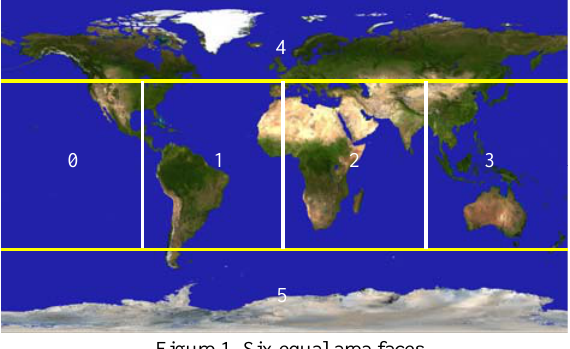
Figure 1. Six equal area faces